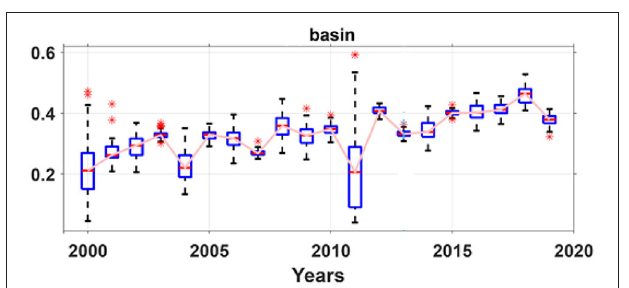
FIGURE 4 | Cropland proportion time series within the basin. The medians are linked by the red